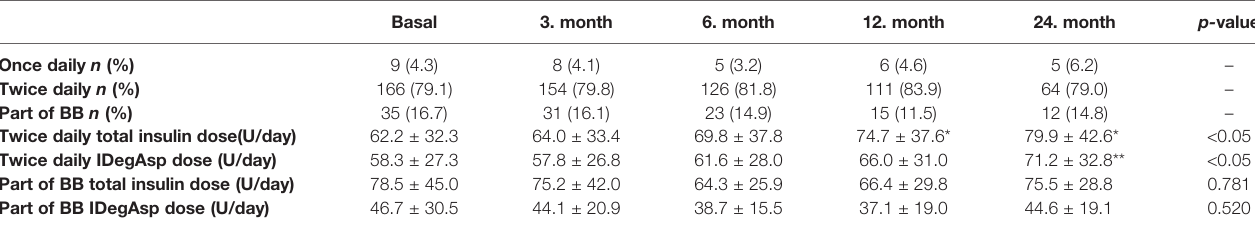
TABLE 2 | Insulin dose frequency and total and IDegAsp insulin requirement in Type 2 DM patients.